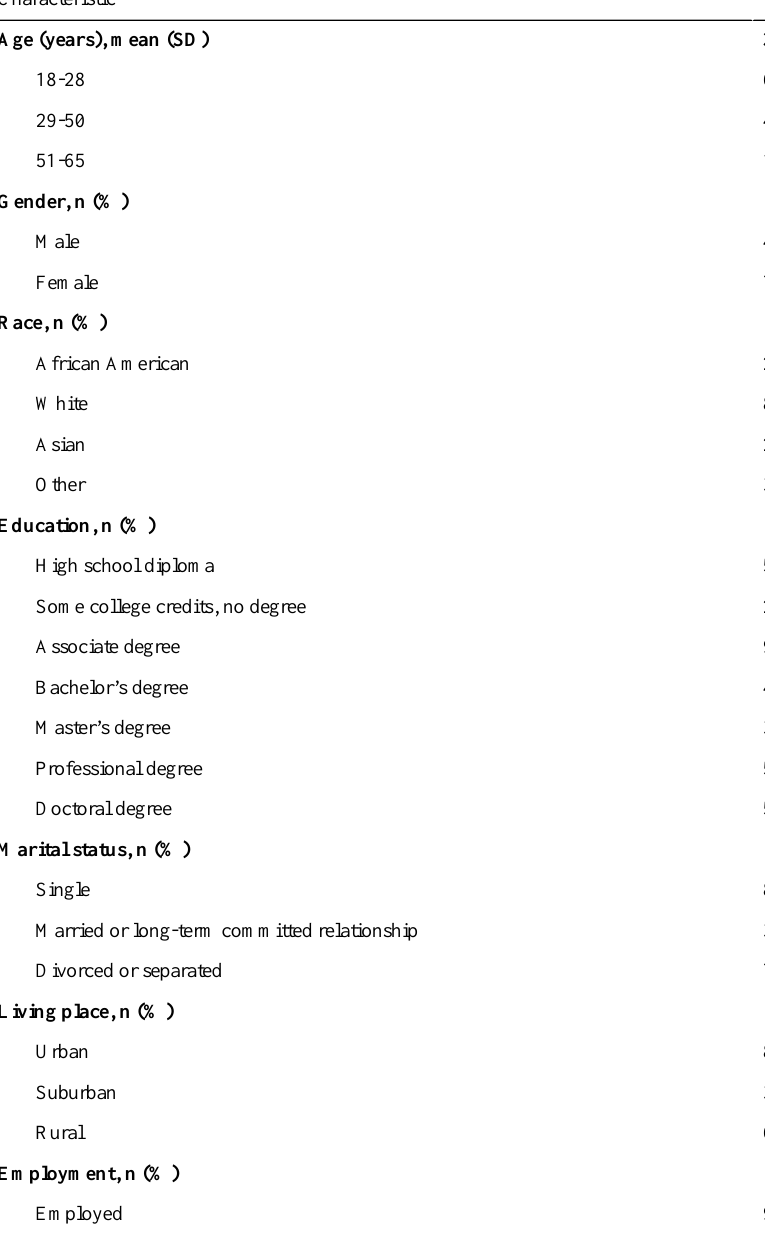
Table 1. Demographic characteristics of the study participants